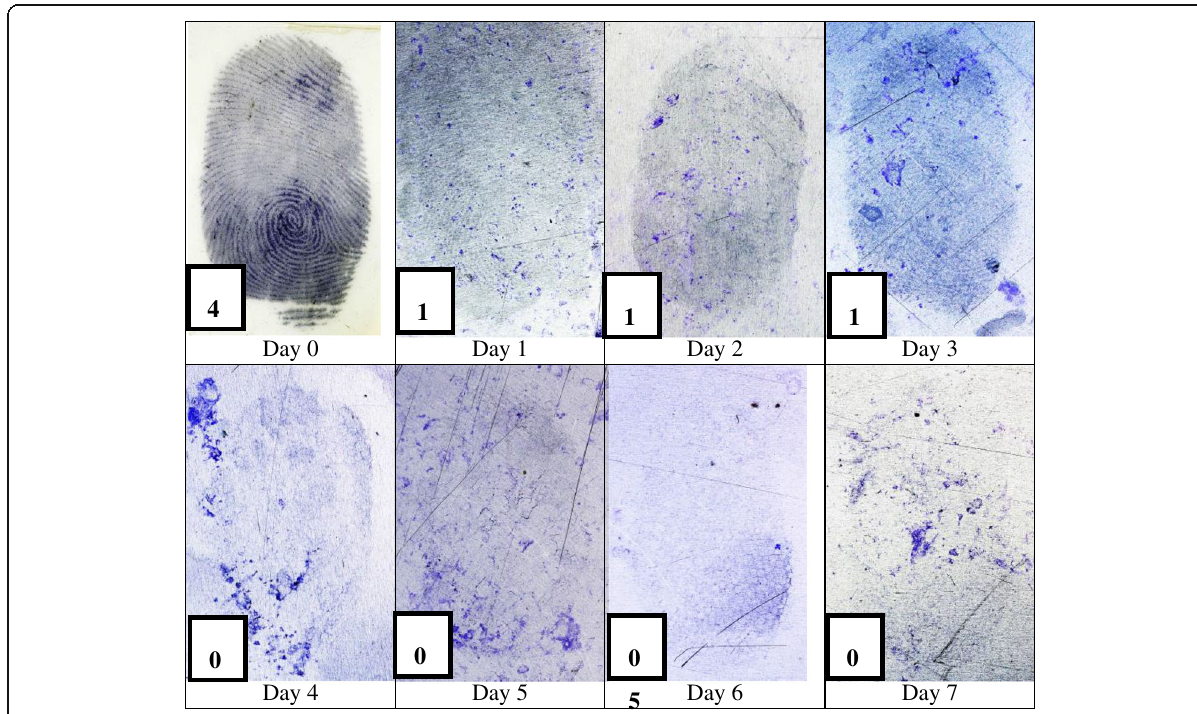
Fig. 11 Fingermarks developed using crystal